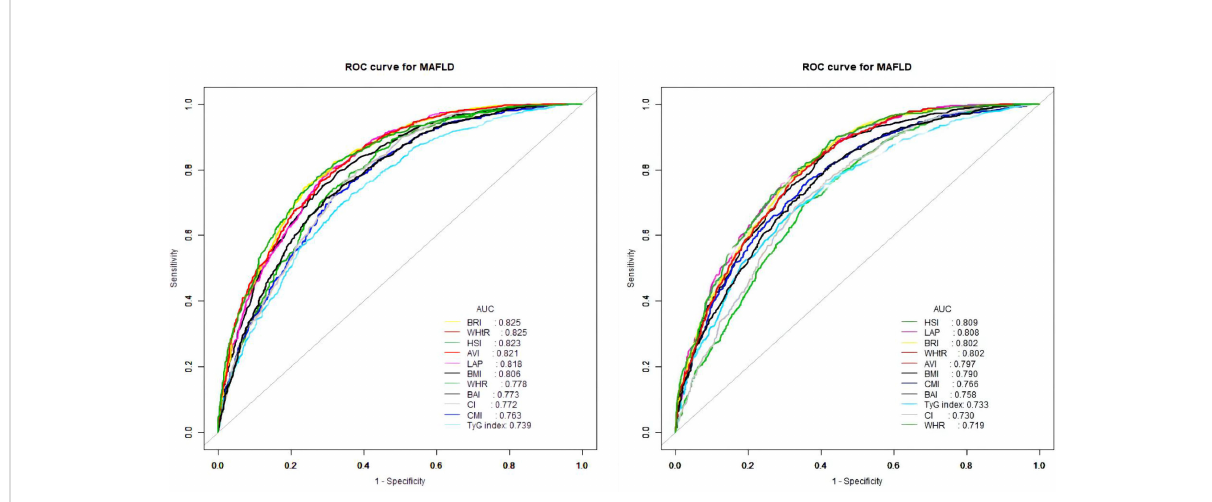
FIGURE 3 Receiver operator characteristic for anthropometric indices in diagnosing MAFLD strati fi ed by gender [(left) males and (right)